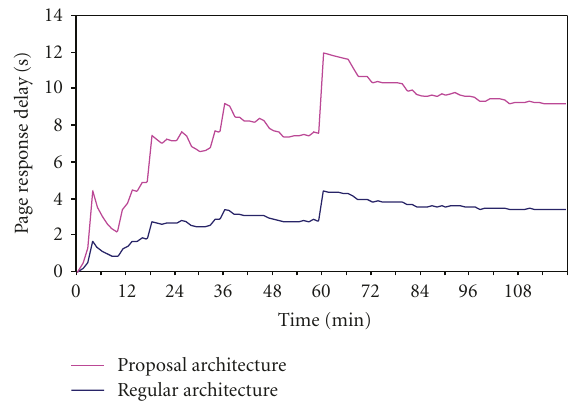
Figure 11: Average delivery delay.